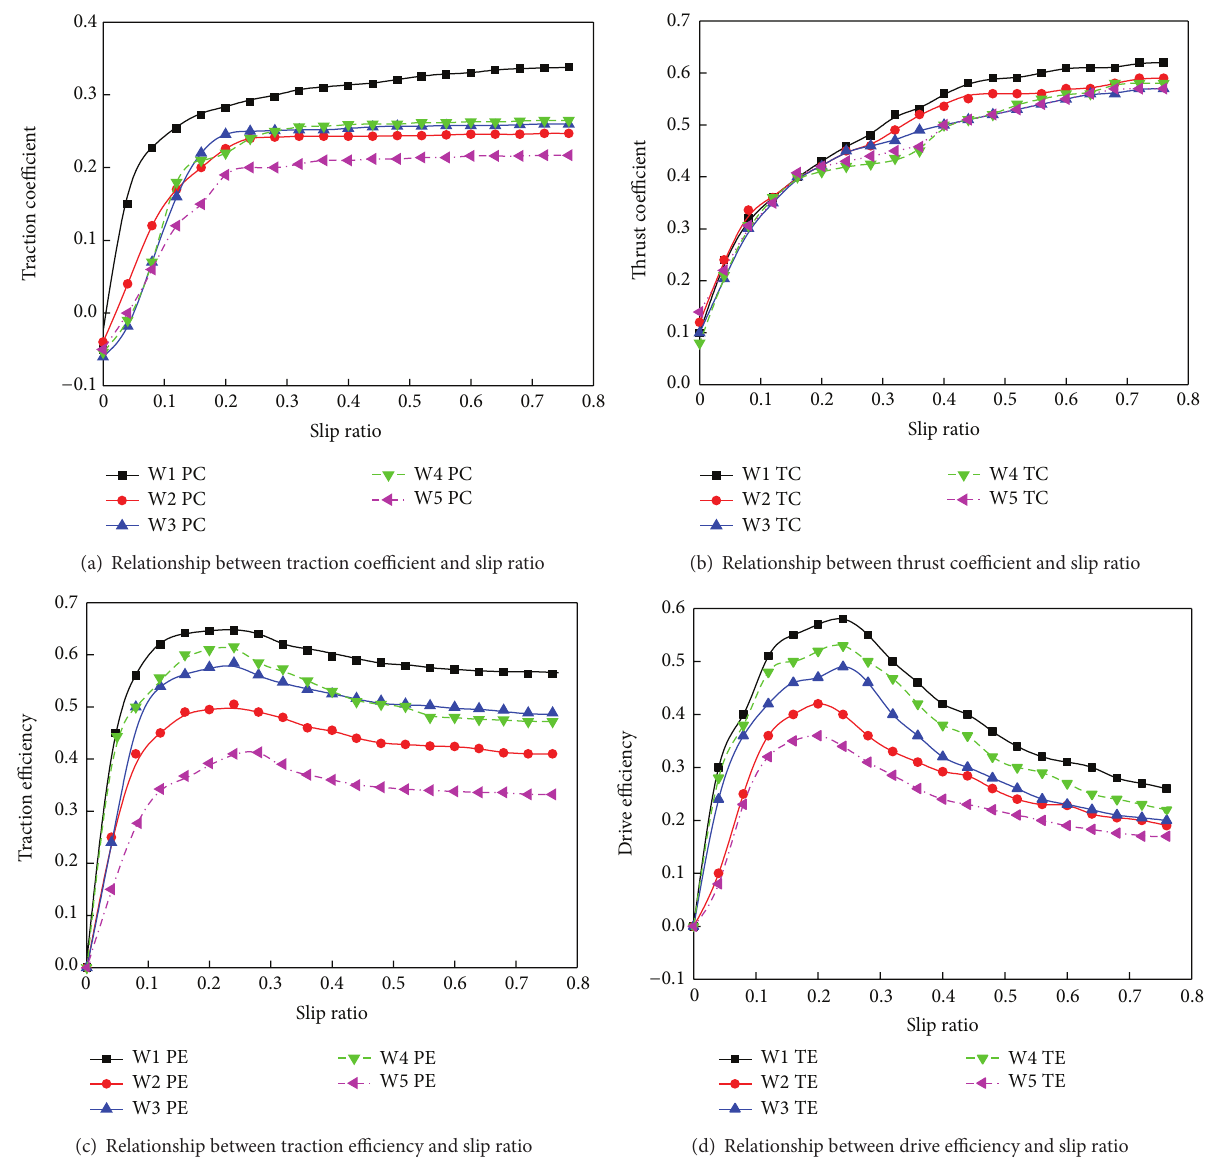
(d) Relationship between drive efficiency and slip ratio Figure 3: Key performance indexes of robot climbing loose sloped terrain versus wheel slip